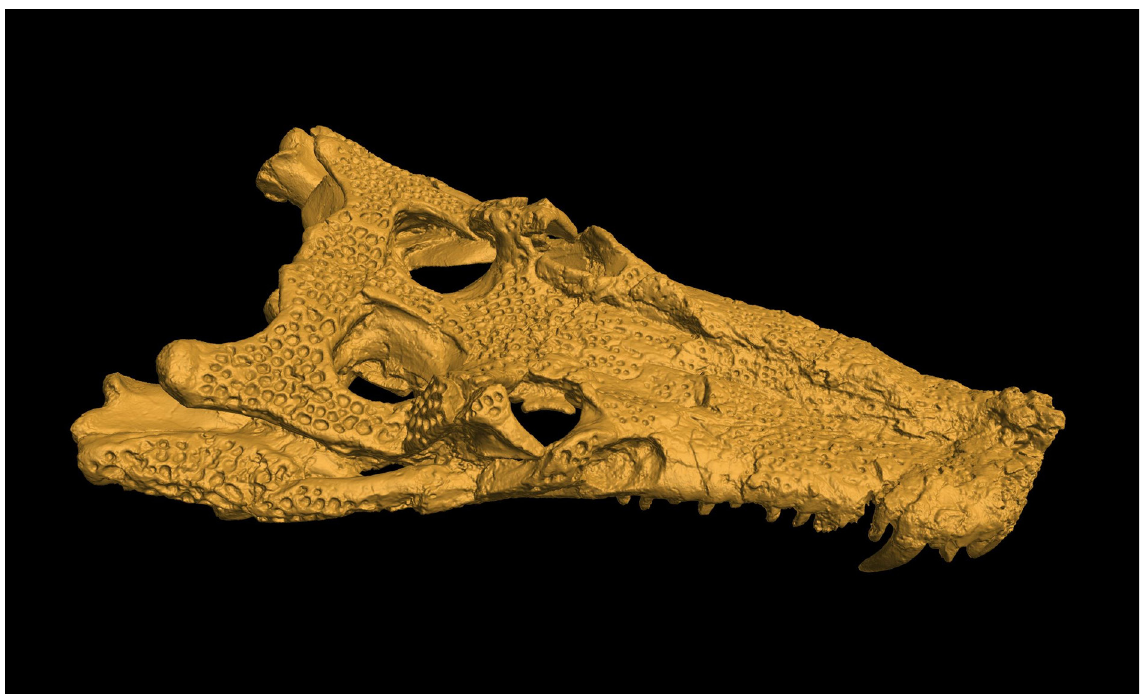
Fig. 3.26. Goniopholis skull. Scanned with the HDI. https://sketchfab.com/models/c58694337a46449f9074b72fcb3c9cf5